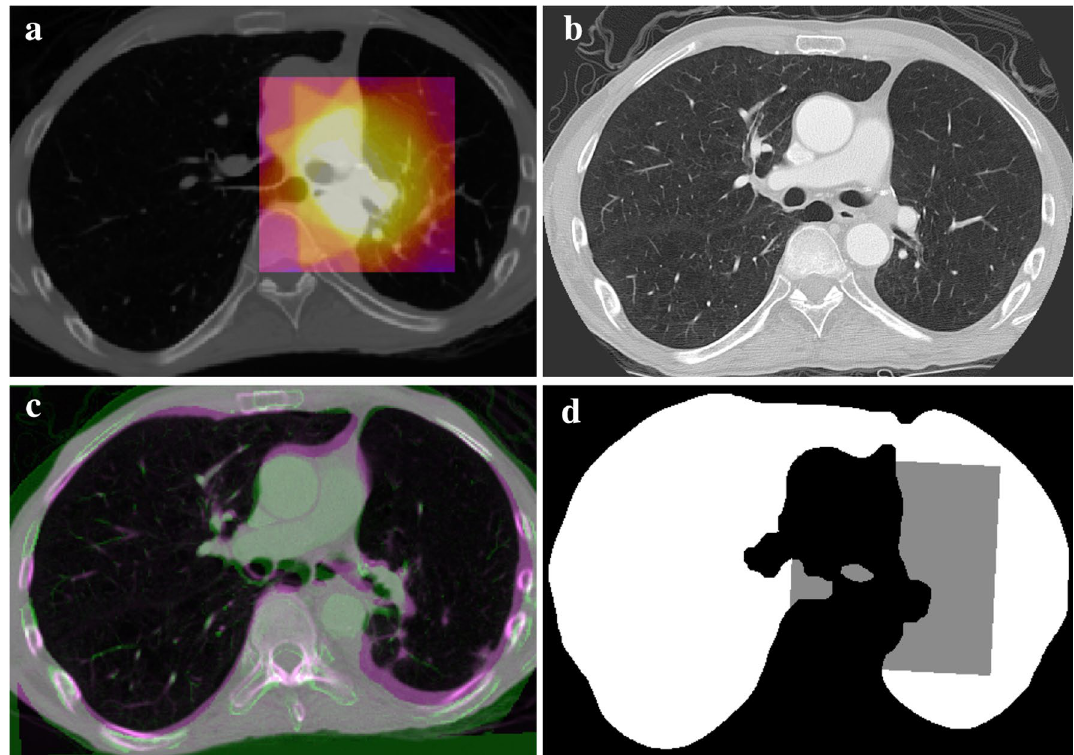
Figure 1. Lung Segmentation and registration results: ( a ) shows for a representative patient a treatment planning chest CT slice through a tumor located within the hilar region. The colorized overlay is the planned dose distribution over a 10 × 10 × 10 cm 3 region centered on the isocenter. ( b ) An axial CT slice at approximately the same anatomical location at the 8-month follow-up time point and in the same patient as ( a ). ( c ) Depicts the result of the rigid body registration of the 8-month follow-up CT to the panning CT at the same anatomical slice location. ( d ) The lung volume mask in white and gray for the 8-month follow-up image. The computed dose grid is transformed from the planning CT image space to the follow-up CT image space and the gray pixels show where the dose grid aligns to pixels in the lung mask of the follow-up image. The region of gray pixels is where the dose–response data is